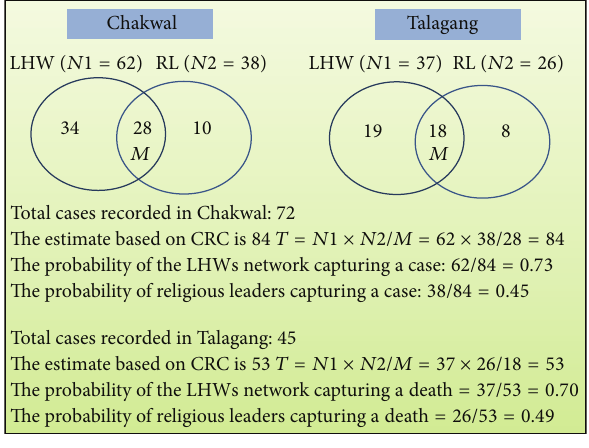
Figure 3: Estimating total PRDs through capture-recapture tech-